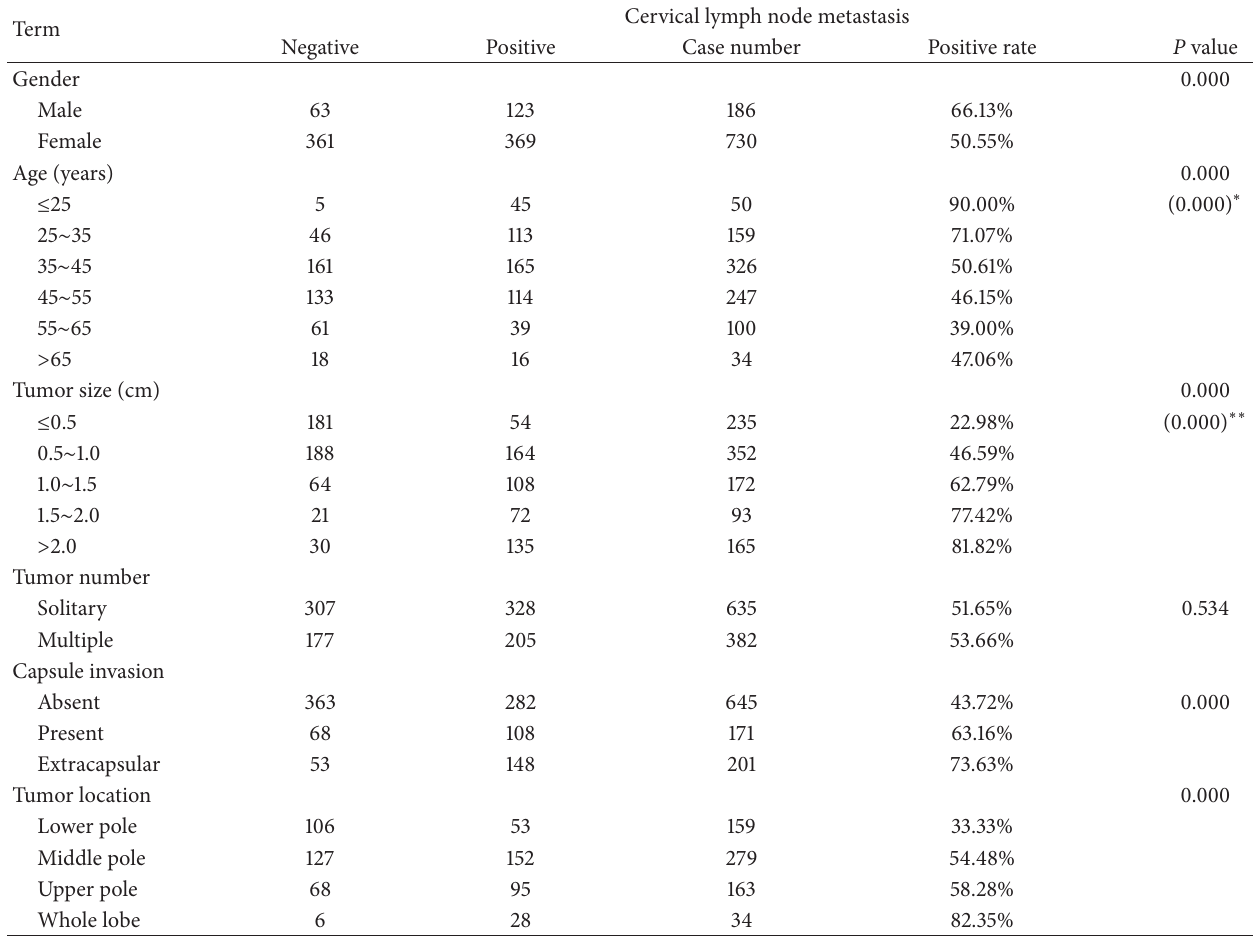
Table 2: Correlation between clinical factors and CLN metastasis: univariate analysis.